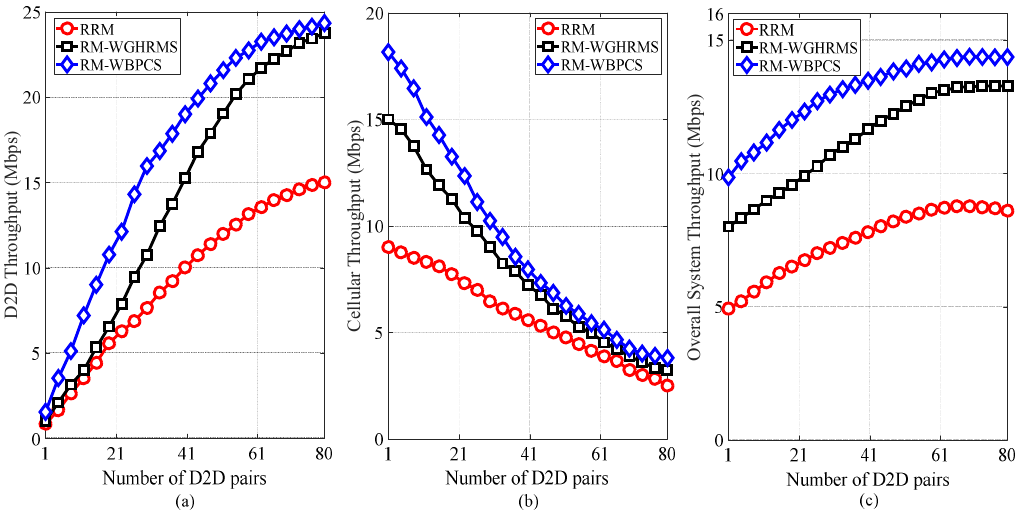
Figure 7. Average throughput analysis with varying numbers of available DPs for ( a ) DPs, ( b ) CUs, and ( c ) the overall system.